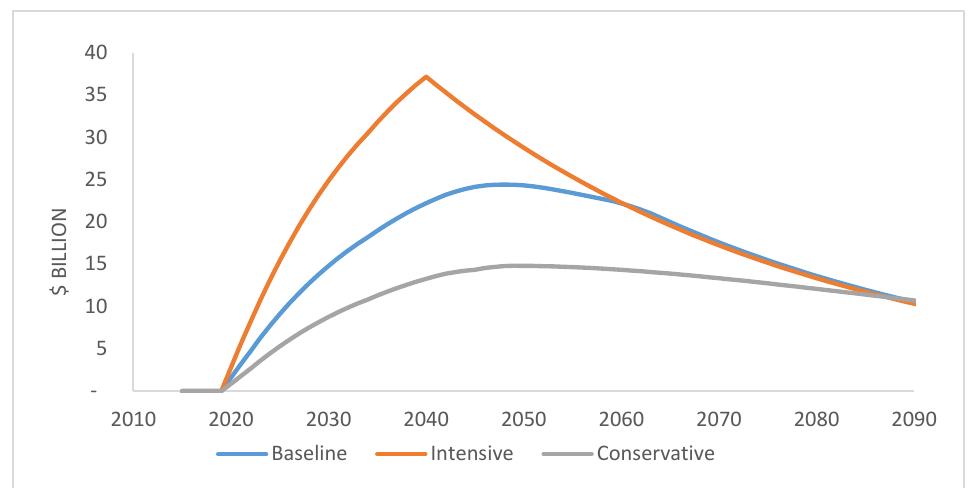
Figure 5. Growth in sovereign wealth fund (SWF) value under the three scenarios in the benchmark scenario.